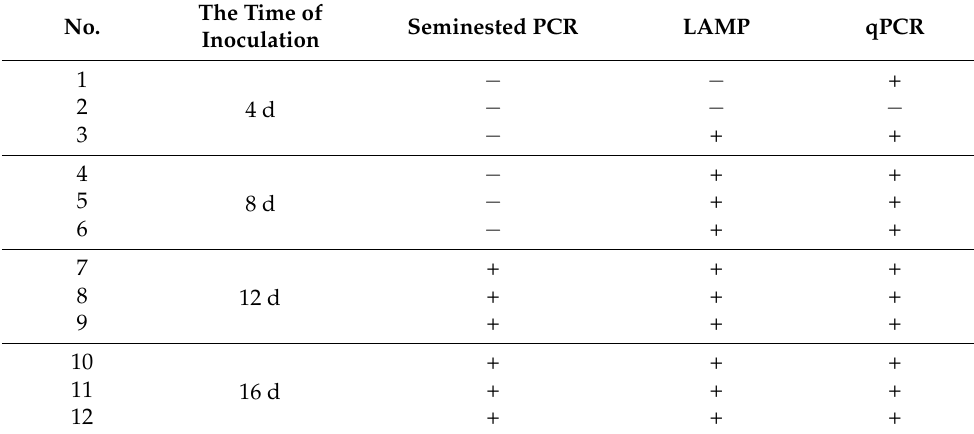
Table 3. The results of artificial inoculation for detecting A. phaeospermum . The Time No.